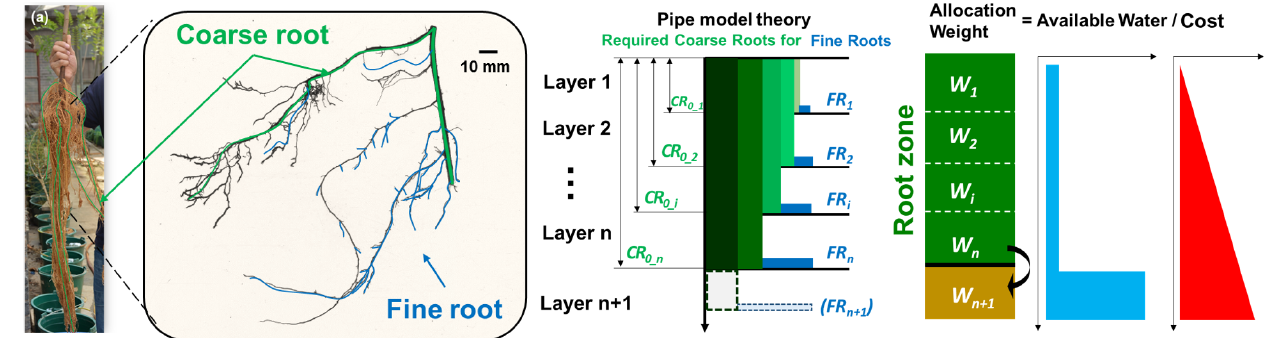
Figure 2. (a) Black locust root system obtained from an experimental pot; (b) scanned image of one root segment consisting of coarse and fine roots; (c) schematic description of pipe model theory adopted for coarse and fine roots; (d) weighting factors for carbon allocation and conceptualized benefit (available soil water for uptake) and cost (carbon